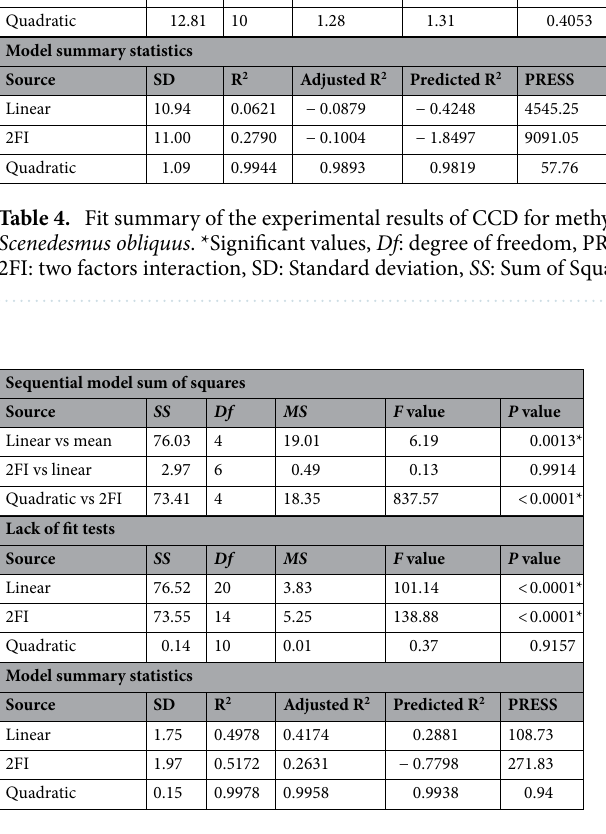
Table 5. Fit summary for experimental results of CCD for lipid production (%) by using Scenedesmus obliquus . *Significant values, Df : degree of freedom, PRESS: sum of squares of prediction error, 2FI: two factors interaction, SD: standard deviation, SS : sum of squares, MS : mean